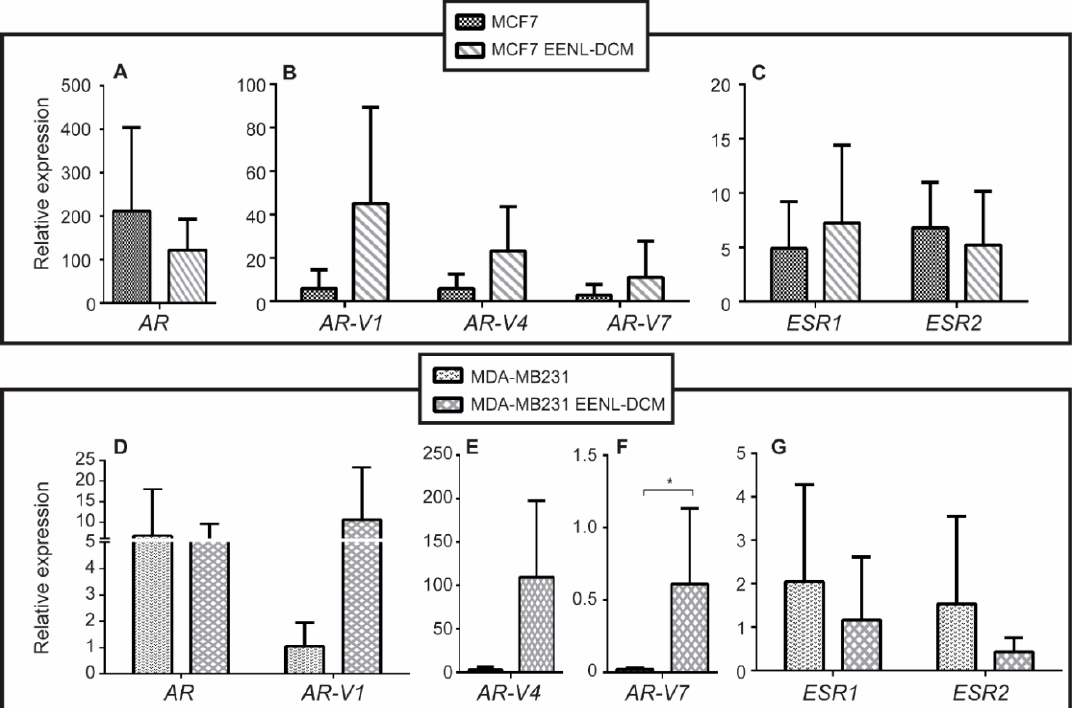
Figure 4. Relative expression of hormone receptors genes after treatment with Ethanolic Extract of Neem Leaves (EENL). Cell lines were treated with 0.03125 μ g/mL of EENL obtained using dichloromethane (EENL–DCM) for 48 h. Relative gene expression levels were evaluated for AR ( A ), AR-V1 , AR-V4 , and AR-V7 ( B ), ESR1 and ESR2 ( C ) in MCF7 cell line. In MDA-MB-231 the relative gene expression levels were evaluated for AR and AR-V1 ( D ), AR-V4 ( E ), AR-V7 ( F ), ESR1 and ESR2 ( G ). The analyses were performed using the comparative Cq calibrated with data from MCF10 * P < 0.05.